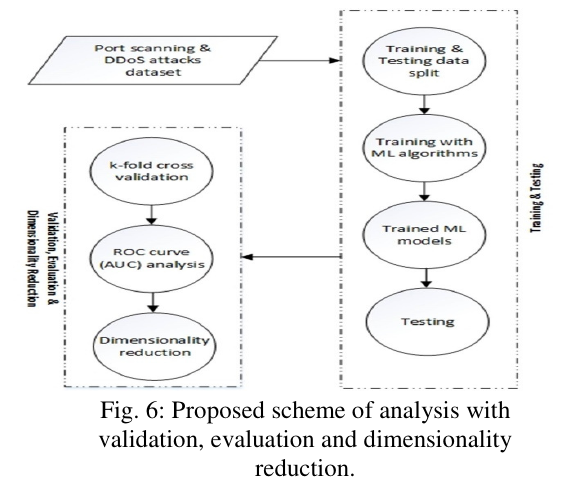
Fig. 6: Proposed scheme of analysis with validation, evaluation and dimensionality reduction.